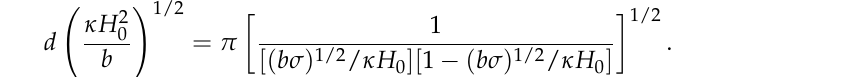
, the surface tension in units of 0